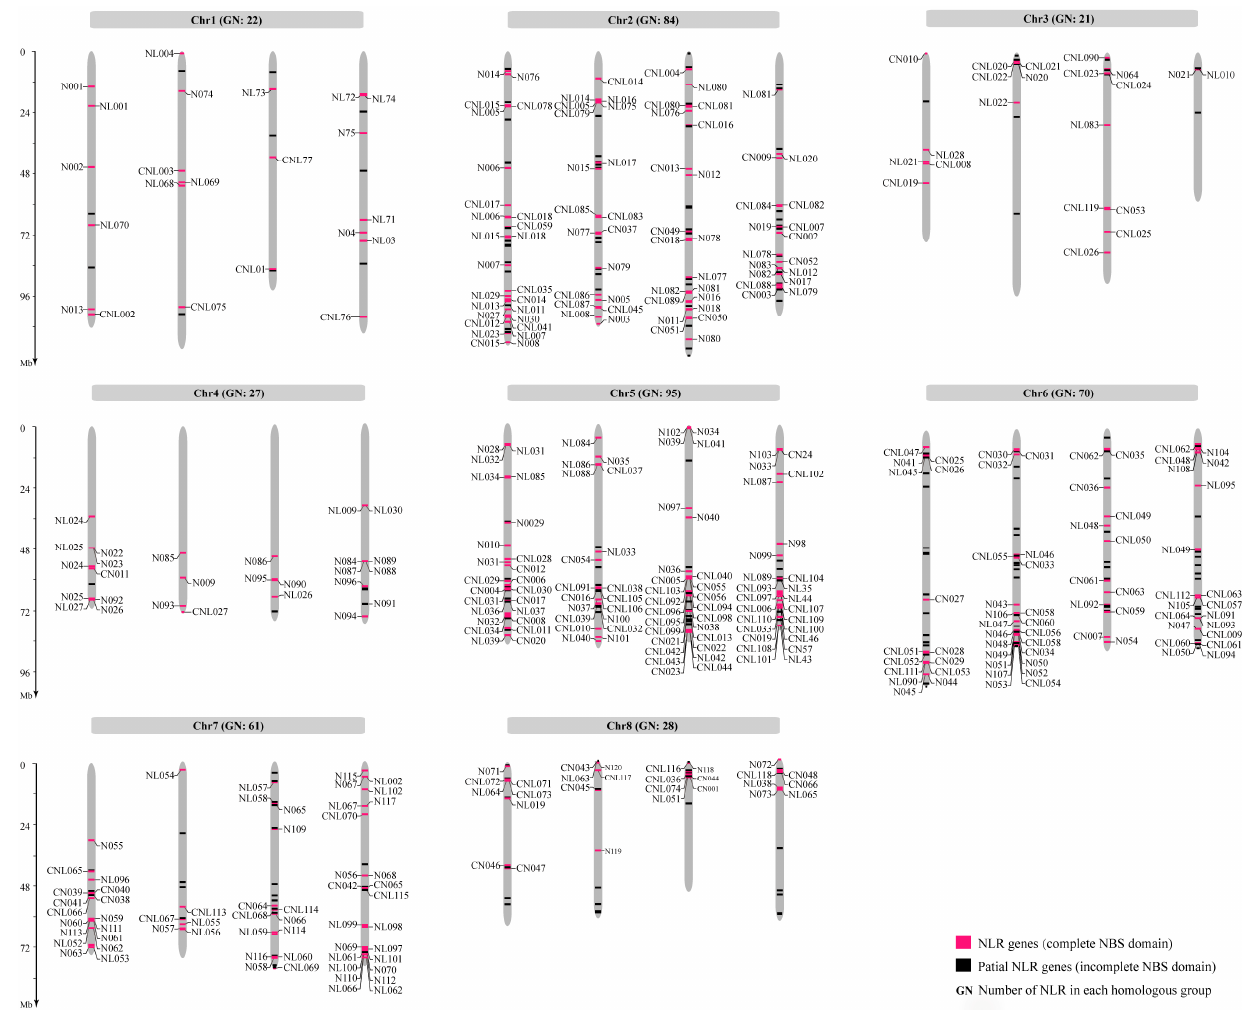
Figure 4. Physical distribution of NLR genes on Saccharum spontaneum chromosomes. All NLR genes (407 NLR genes encoding the complete NBS domain, and 317 for partial genes) were mapped to eight homologous groups (Chr1–Chr8) of four members (A–D) each (32 chromosomes). Red lines on the chromosomes represent NLR genes encoding the NBS domains and black lines represent partial NLR genes encoding the incomplete NBS domains.